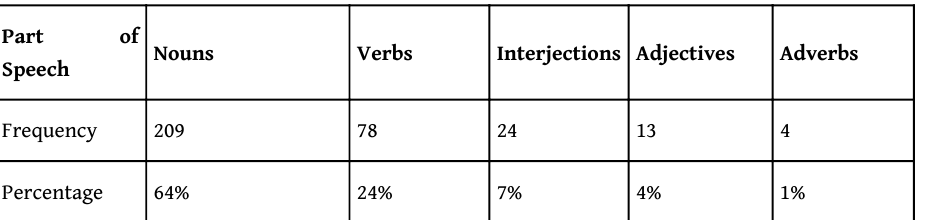
Table 1: Table of vocabulary per grammatical form cited by the participants